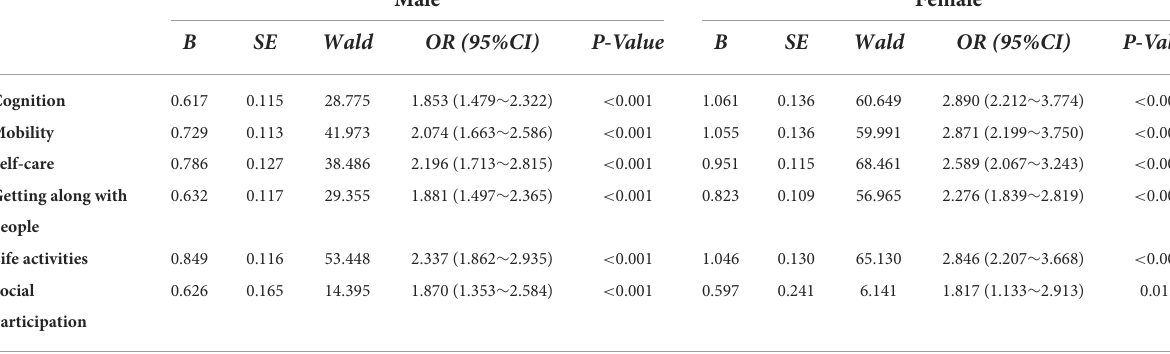
TABLE 3 Effects of cut-off values of age for disability in terms of six dimensions by